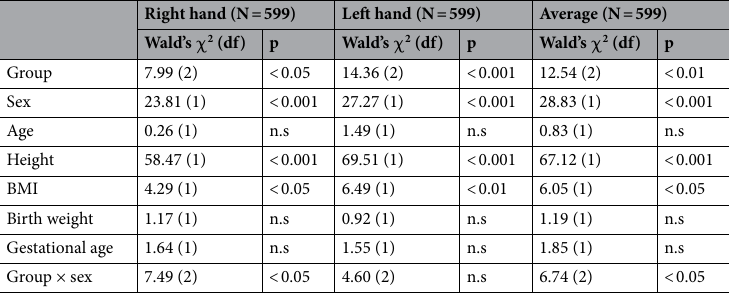
Table 3. Results of the analysis of covariance by GLM, where HGS was dependent